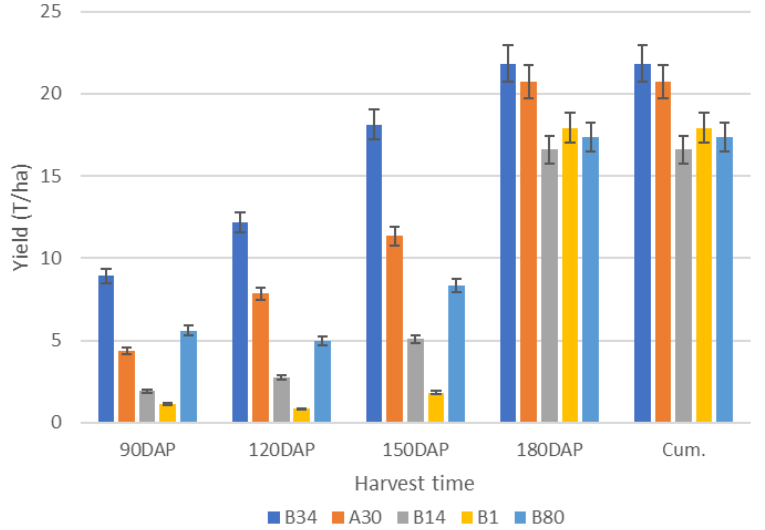
Figure 4. Growth pattern of continuous storage root formation and bulking of four sweetpotato genotypes representing different growth patterns over four harvest times (averaged across four environments). Note: DAP = days after planting; Cum. = Cumulative yield. Growth trend for genotypes A30, A14, B1 and B80 shows CSRFAB with increased yield overtime. The yield increase starts slowly and drastically increases at a late stage (150 DAP). The cumulative yield is the same with the last harvest (180 DAP).